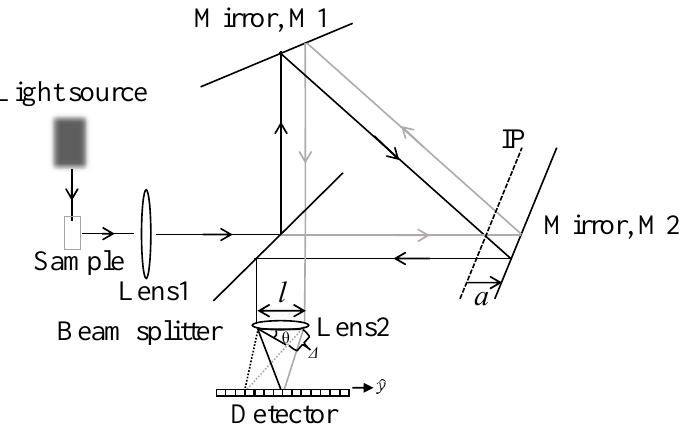
Figure 1. A static modulated Fourier transform spectrometer composed of a modified Sagnac inter- ferometer.